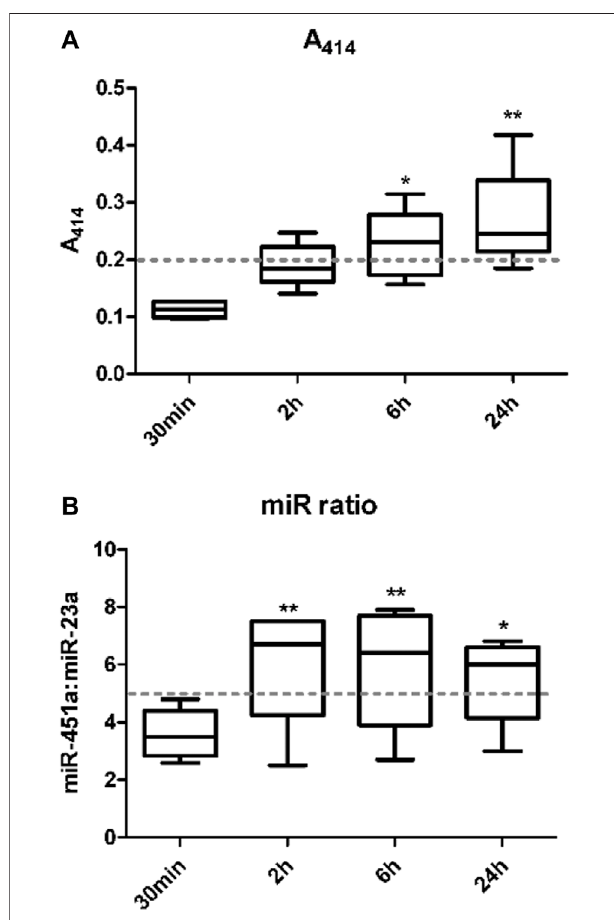
FIGURE 1 | The level of hemolysis is higher with increasing whole blood holding time. Hemolysis in plasma samples was measured. The fi rst method used measurement of the absorbance of hemoglobin at 414 nm using a NanoDrop 1000 spectrophotometer (A) . The second method was by examining the ratio of miR-451a to miR-23a-3p (Delta Cq (hsa-miR-23a-3p – hsa-miR-451a)) referred to as miR ratio using RT-qPCR (B) .